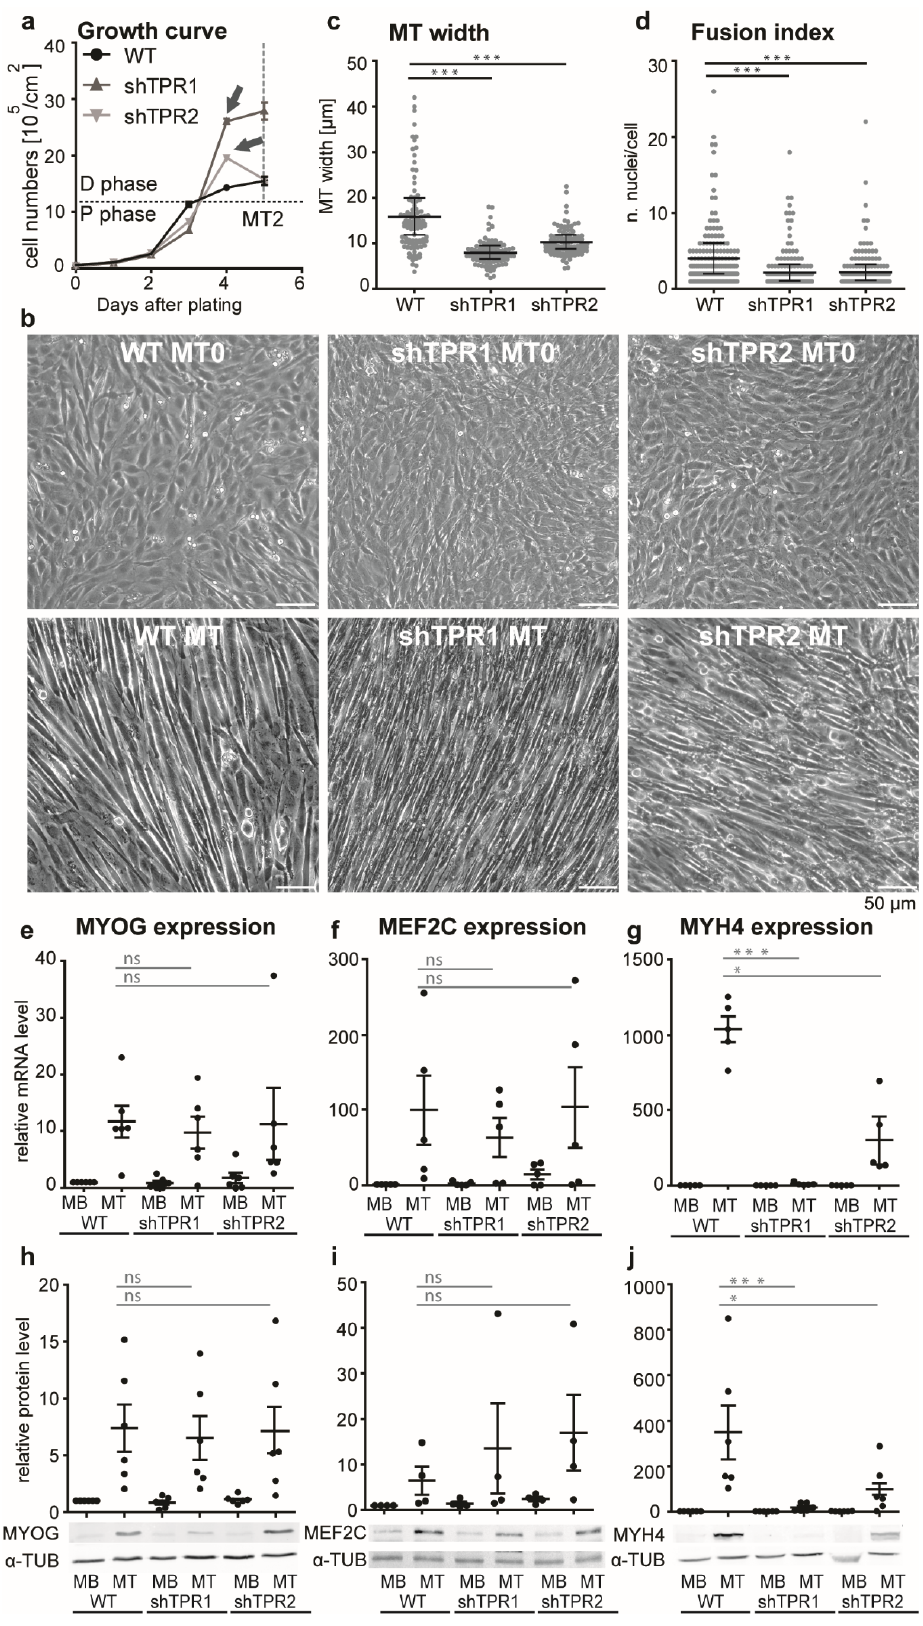
Figure 2. TPR is important for C2C12 myogenic differentiation. ( a ) Growth curve of WT and TPR- depleted C2C12 cells shows decreased proliferation rate (see proliferation phase, P) in